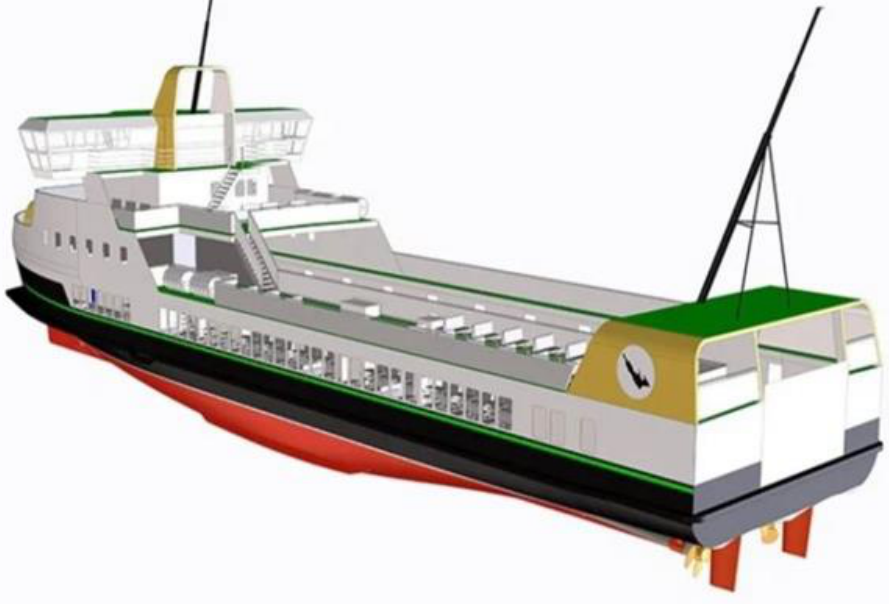
Figure 7. First e-ferry, Ellen [56]. She is a small–medium sized car and passenger ferry, designed to meet the needs for transportation in island communities and coastal zones. The ferry can transport 31 cars or 4–5 trucks, and between 147 (winter) and 196 (summer) passengers. The ship’s drivetrain and power management system were provided by Danfoss Editron, a division of